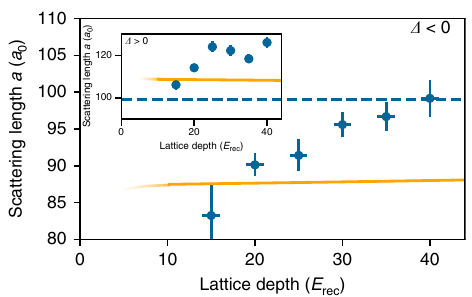
Fig. 4 Intensity-dependent interaction shift. Measured interaction shift Δ U , for different coupling laser intensities and a detuning Δ = 2 π × 18 MHz. The data point at ≈ 340 W cm − 2 corresponds to an atomic Rabi frequency of Ω = 2 π × 810 kHz as in Fig. 3. The data fi ts well to the two-level model for low intensities (orange); however, for strong driving, we observe an increase of the interaction. The red line is a power law fi t I α , which yields an exponent of α = 1.2(3). Error bars correspond to statistical errors from the fi tting procedure. The inset illustrates the back action of the dissipative effects on the Rydberg OFR. Ions shift the molecular resonance to the red, while Rydberg excitations lead to a blue shift. The dashed yellow line denotes the unperturbed resonance and the solid yellow line denotes the shifted resonance. Depending on the laser detuning Δ (sketched as purple lines), the effective detuning from the resonance is either enlarged ( Δ < 0) or reduced ( Δ > 0)